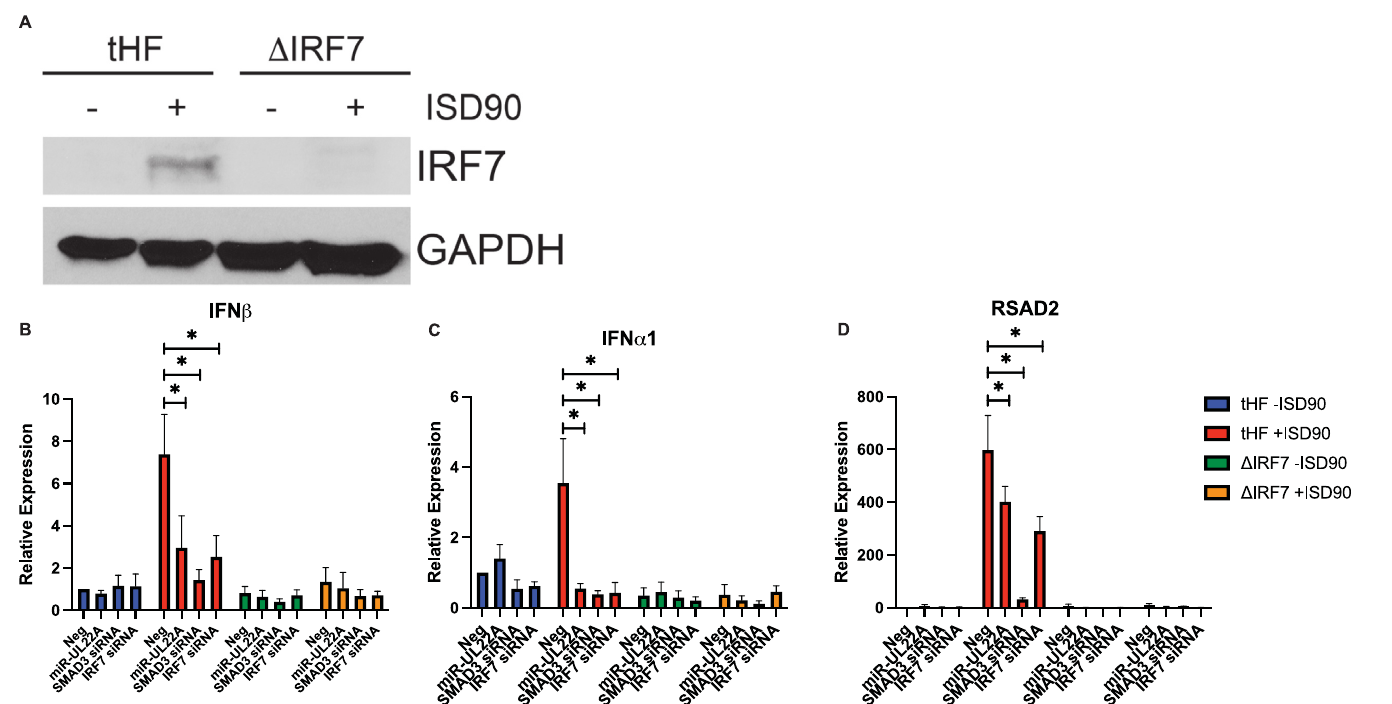
Fig 6. SMAD3 participates in IRF7-mediated signaling. (A) tHF or Δ IRF7 tHFs were transfected with ISD90 for 16 hours. Protein lysates were subjected to immunoblotting for IRF7 or GAPDH. (B-D) tHF or Δ IRF7 tHFs were transfected with negative control, miR-UL22A mimic or SMAD3 or IRF7 siRNA for 48 hours after which cells were additionally mock transfected or transfected with ISD90 for 16 hours. RNA was isolated and subjected to qRT-PCR for IFN β , IFN α 1 or RSAD2. All experiments were performed in triplicate. � p < 0.05 by two tailed Student’s t test.